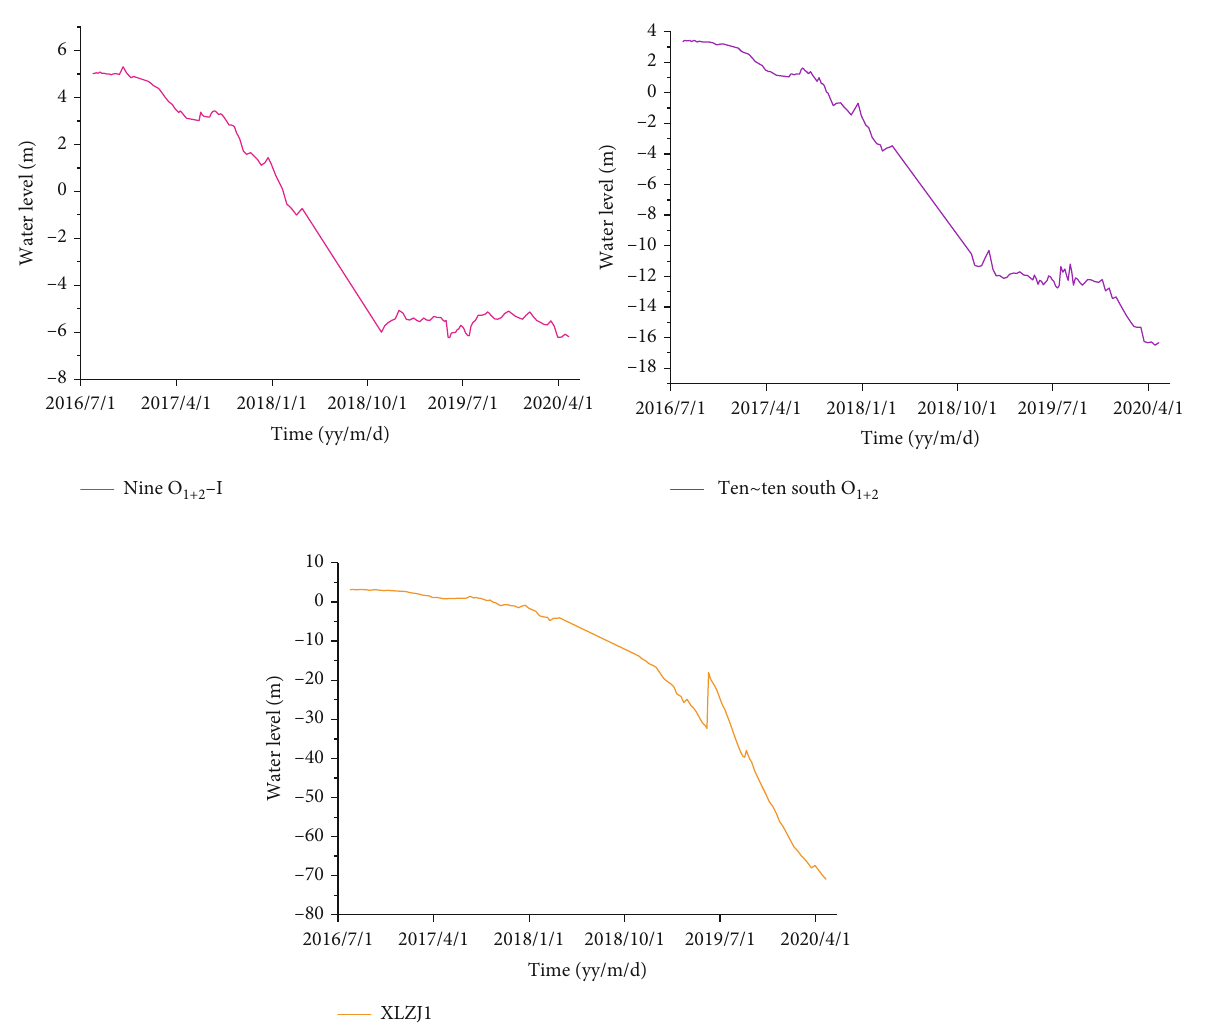
Figure 10: Hydrological observation well dynamic curve of Ordovician and Cambrian limestone aquifers in the South No.1 mining area before and after water damage prevention and